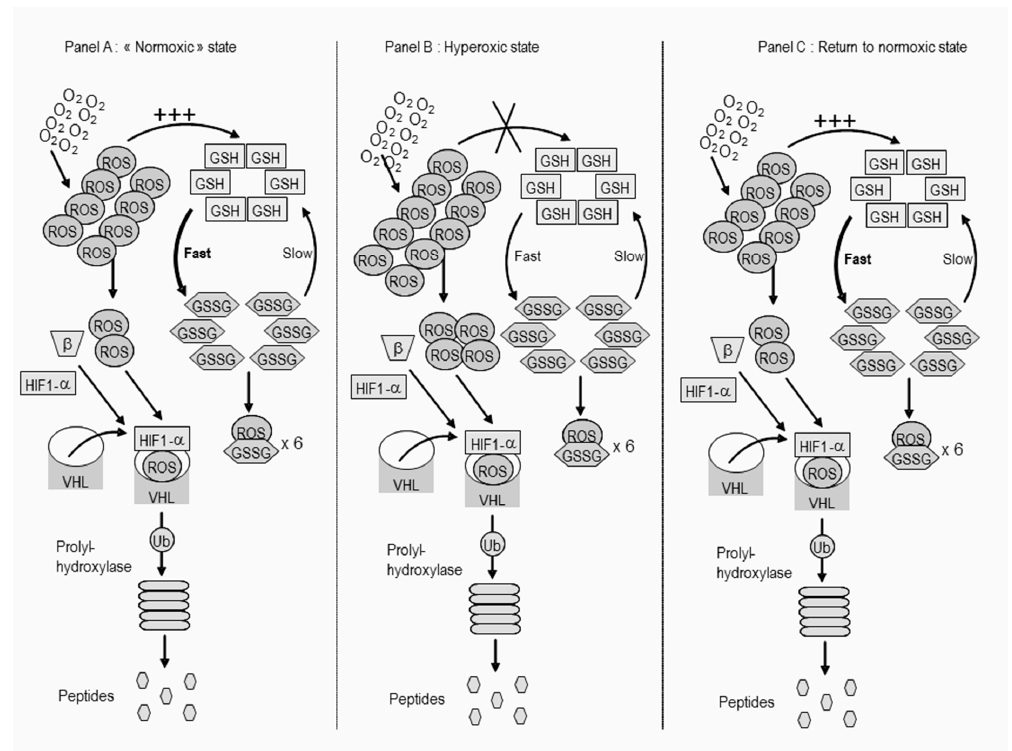
Figure 1. Intracellular mechanisms postulated for the ‘‘Normobaric Oxygen Paradox’’ in the hyperoxic cancer cell. We hypothesize that in the normoxic state, the glutathione synthetase enzyme activity is already at its maximum, thus, an O 2 increase cannot induce GSH increase and therefore leads to high levels of reactive oxidant species ( ROS). Returning to the normoxic state (of a cancer cell) implies that GSSG needs to be reduced back to GSH. This process is rather slow (glutathione reductase works at the expense of NADPH and is thus limited by the conversion rate of glucose). It takes a considerable amount of time before a sufficient level of GSH is attained to restore the optimal GSH-to-GSSG ratio. The inactivation of HIF-1 should be maintained for a longer period of time as a result of this process. (Modified and reproduced with permission from [27].).